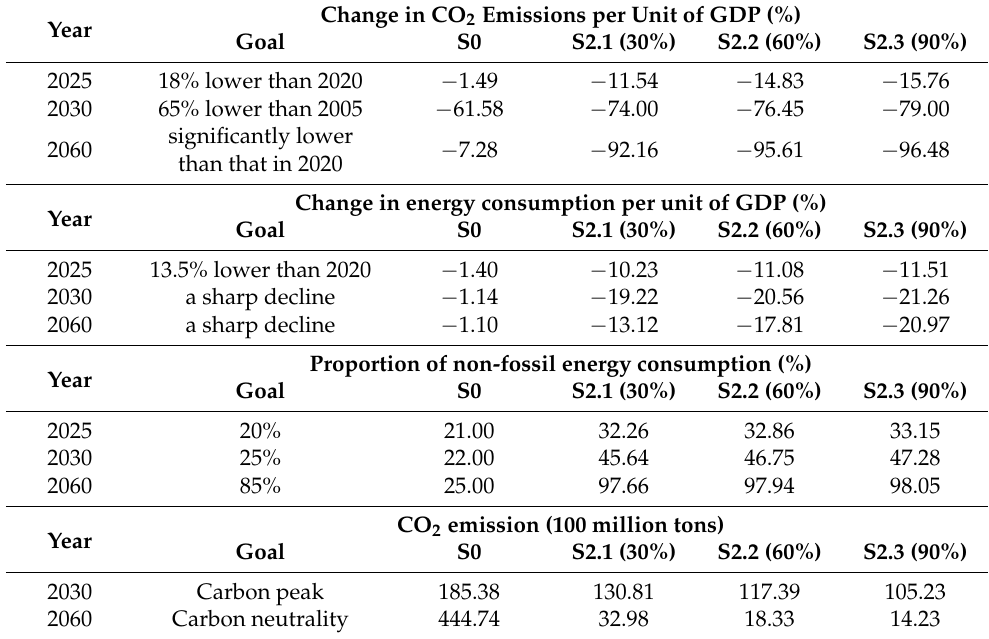
Table 5. Comparisons among different scenarios and expected